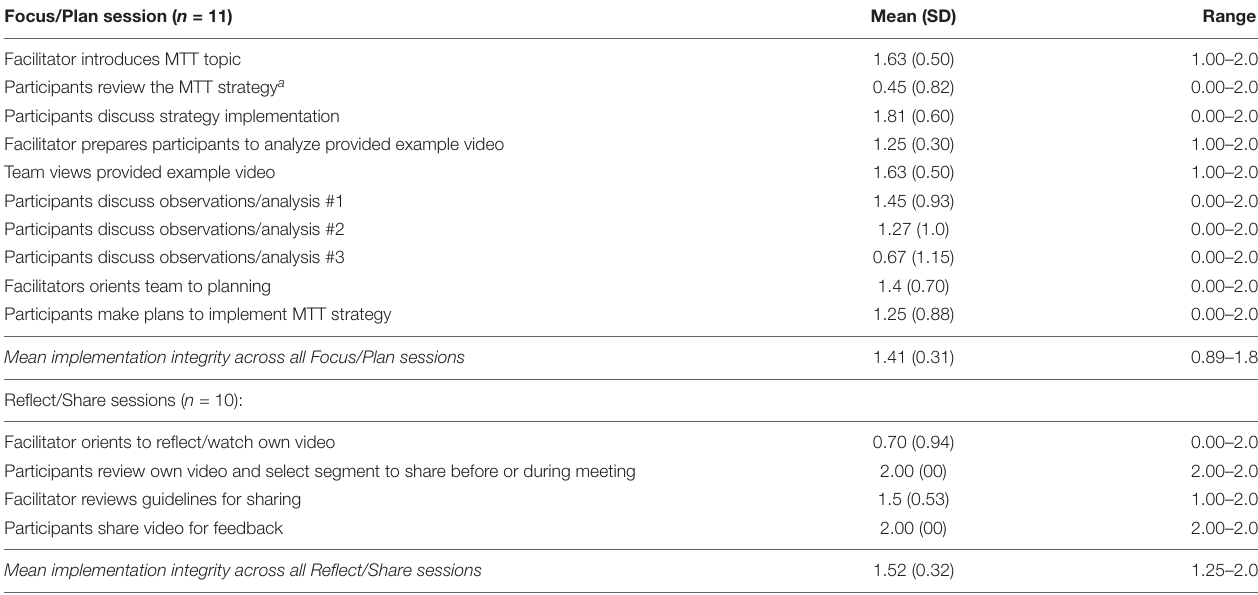
TABLE 4 | Observed MTT implementation integrity during focus/plan and reflect/share